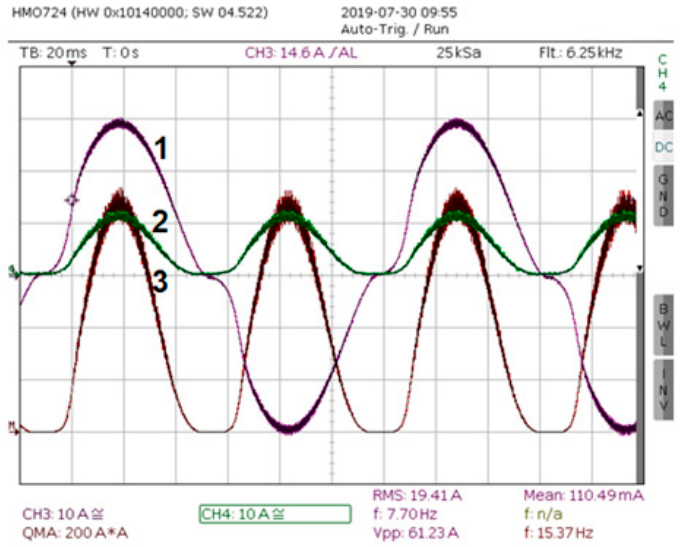
Figure 10. Time plots of current (1) and the square of the current supplying the trolley wires and carrier line (2) and the DC supply current (3).